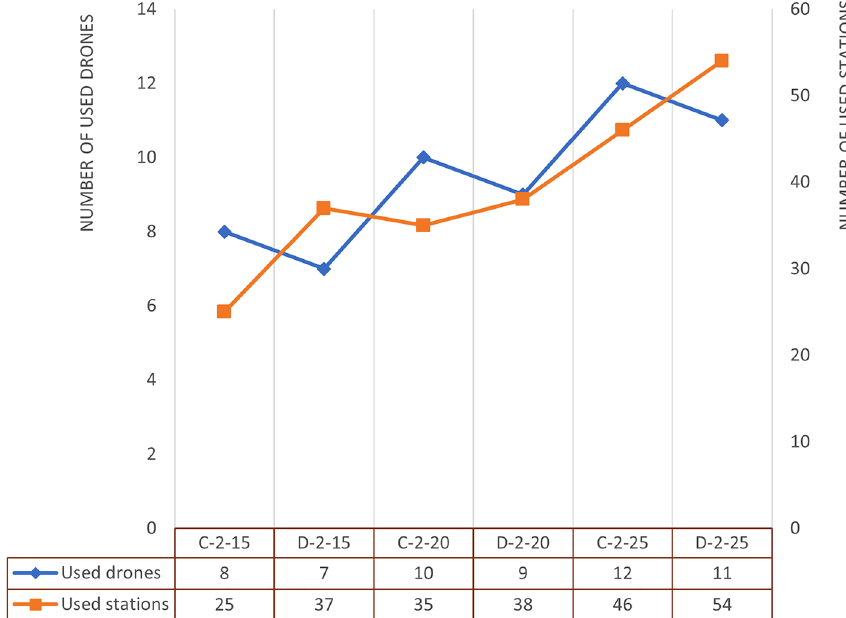
Figure 5. Number of stations and drones used under different scenarios with 2